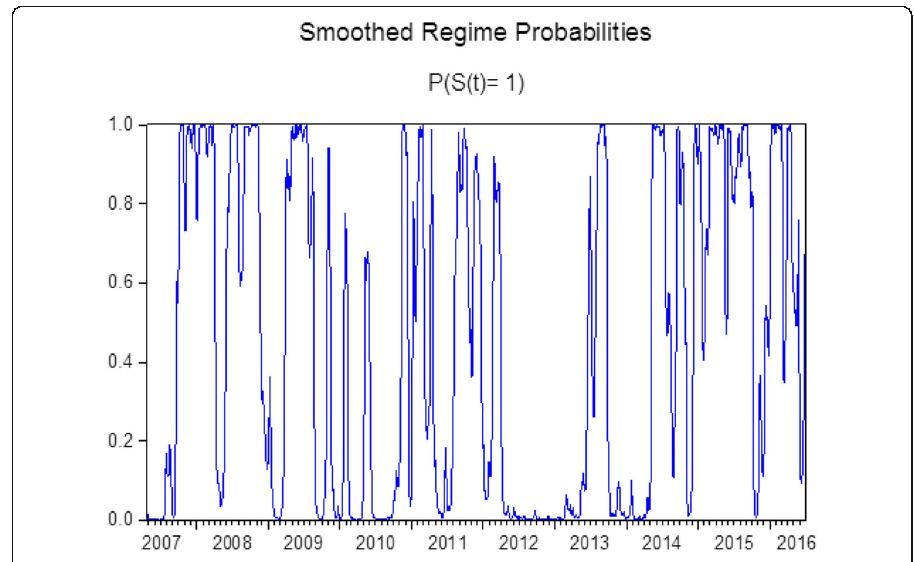
Fig. 6 Smoothed Regime probabilities of Indian Remote Stock Index